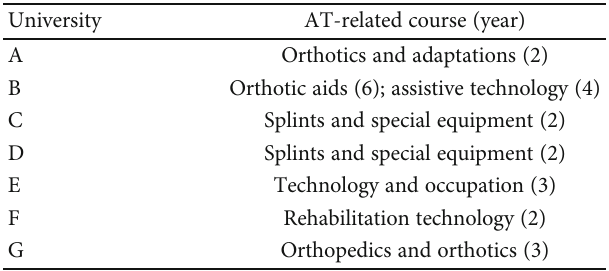
Table generated by the authors from program study plans available online. Occupational Therapy programs in Colombia vary between 4 and 5 years in